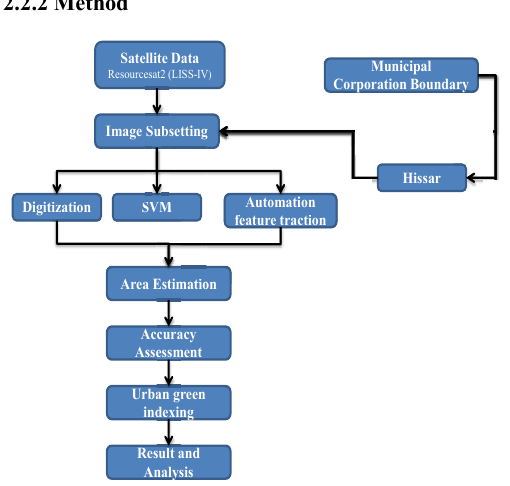
Figure 2. Paradigm of the methodology applied for the